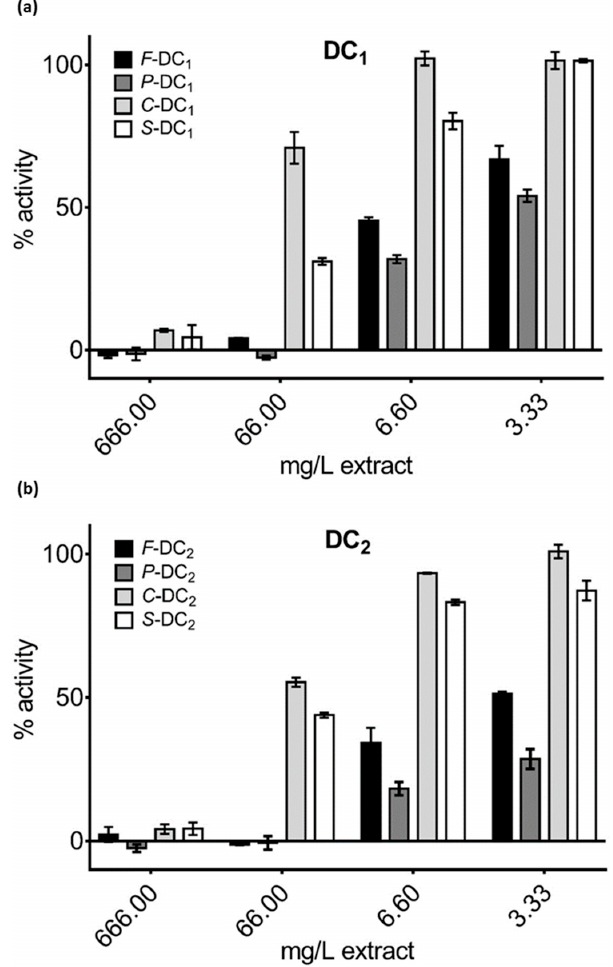
Figure 2. Residual activity of protein disulfide isomerase 3 (PDIA3) in the presence of ( a ) DC 1 and ( b ) DC 2 extracts.